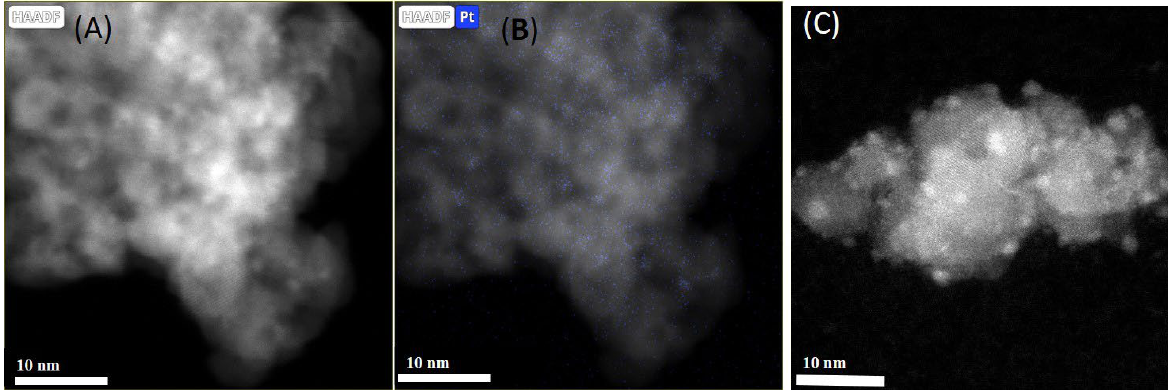
Figure 3. ( A ) HAADF-STEM images of the 1.3 wt.% Pt/CeO 2 and ( B ) STEM-EDX map analysis on the same area indicating the Pt distribution. ( C ) Pt-particles on 1.3 wt.% Pt/CeO 2 after reaction.